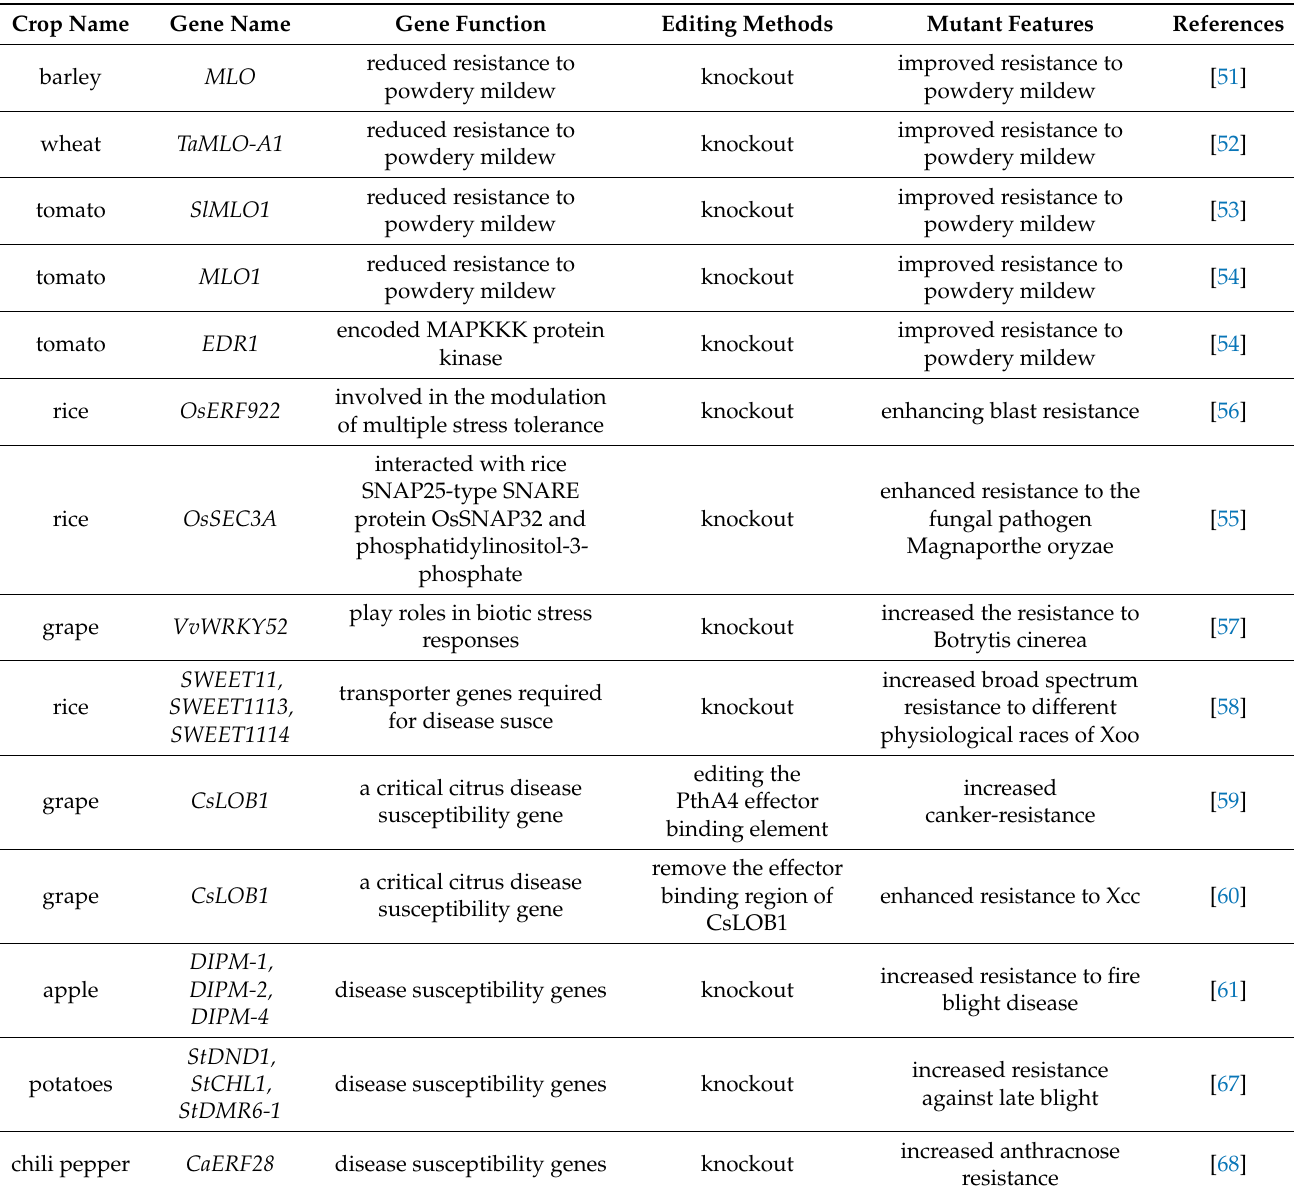
Table 1. Examples of genes from various crops that have been modified by the CRISPR/Cas9 system to increase disease